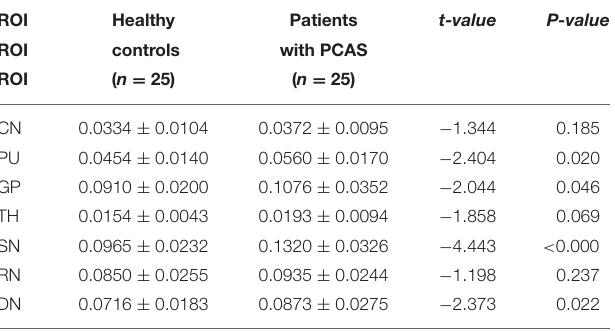
TABLE 3 | Susceptibility (ppm) comparisons in gray matter nuclei between healthy controls and patients with PCAS. ROI Healthy Patients t-value P-value ROI controls with PCAS